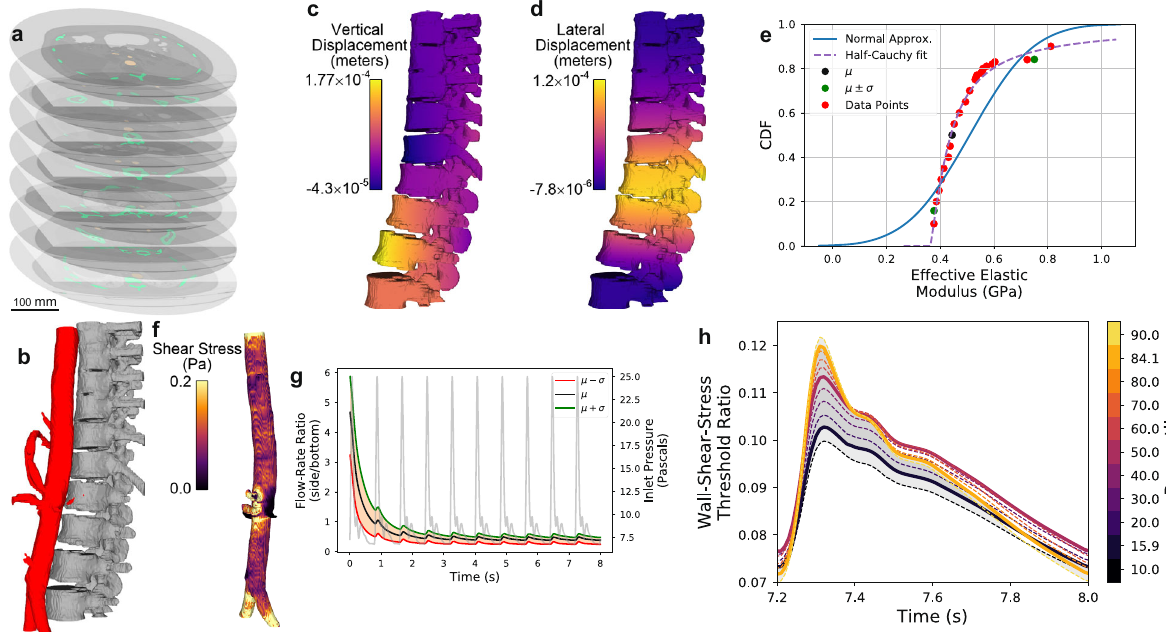
Fig. 5 A multi-class, multi-physics uncertainty analysis of a CT scan of a human torso. a 2D slices of the CT image labels for the spine and aorta overlaid in green and orange, respectively. b A 3D visualization of the μ -percentile segmentation of both classes (spine and aorta). Visualization of spine axial compression simulation showing c vertical displacements, d lateral displacements, and e the resulting uncertainty distribution in the effective Young ’ s modulus, including distribution estimates. f Visualization of the wall shear stress in the aorta resulting from a fl ow simulation. g Prescribed aorta inlet pressure pro fi le (gray) overlaid on the time-dependent outlet side-to-bottom fl ow rate ratio, including uncertainty bounds. h Aorta wall-shear-stress threshold ratio for each percentile segmentation, with the standard segmentations shown as thick solid curves. The dark gray-shaded region emphasizes the curves bounded between ( μ + σ )- and ( μ − σ )-percentile segmentations, whereas the light gray-shaded region highlights the space between the 10- and 90-percentile